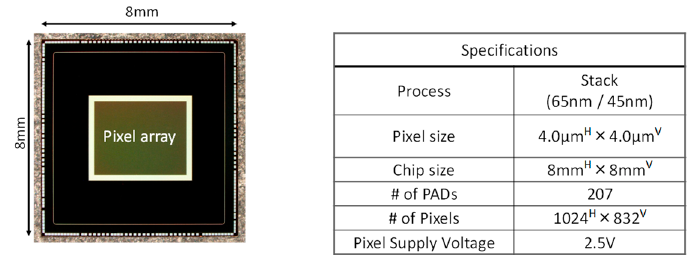
Figure 6. Chip micrograph and specifications of our stacked back side-illuminated voltage domain global shutter complementary metal-oxide-semiconductor (CMOS) image sensor.